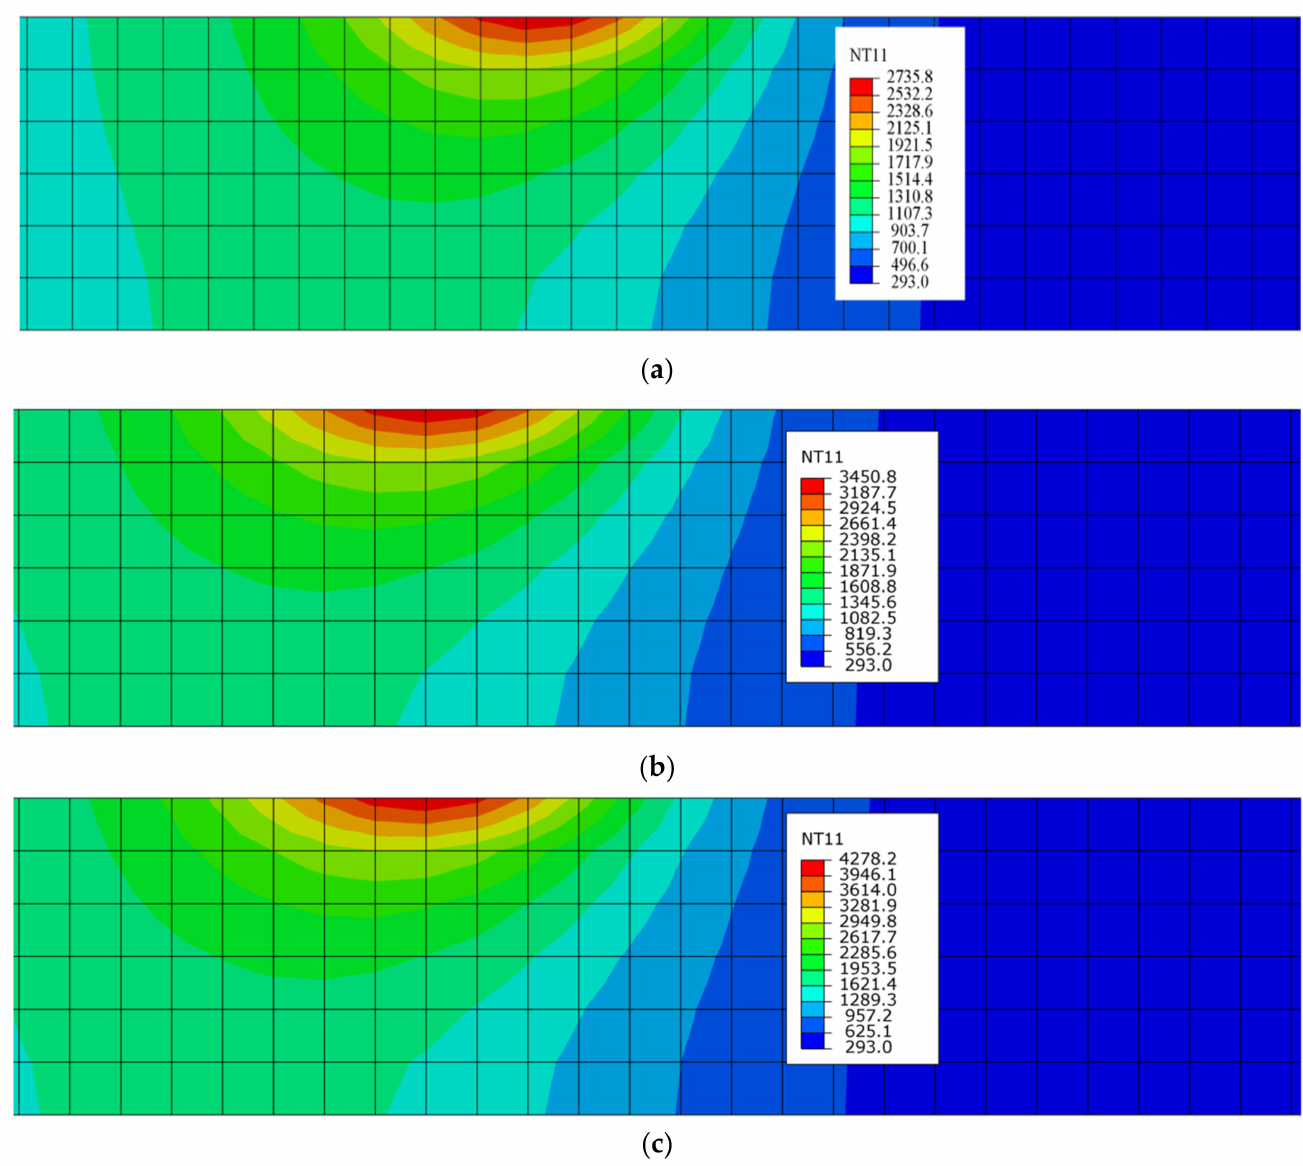
Figure 5. Simulation of the temperature field of silicon carbide crystal material based on Abaqus with varying laser powers at 0.08 s: ( a ) 15 W, 1500 mm/s; ( b ) 20 W, 1500 mm/s; ( c ) 25 W, 1500